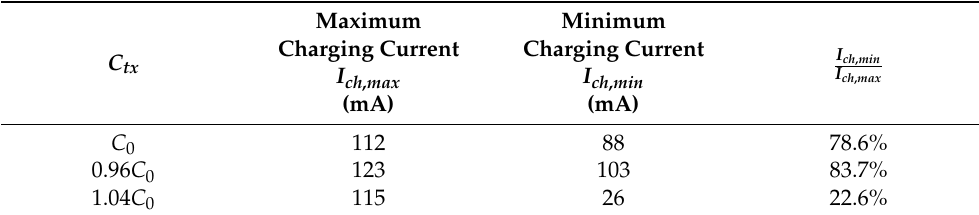
Table 5. Summary of simulation results of the proposed equivalent circuit model of wireless-charging hanger system.